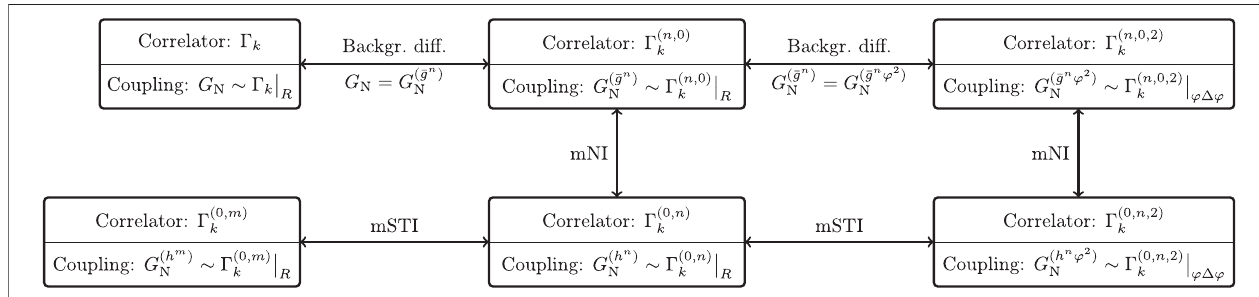
FIGURE3| Displayed aretherelations betweenbackgroundand fl uctuationcorrelationfunctionsintermsofsymmetryidentities.Thebackgrounddiffeomorphism symmetry 46 remainsunbrokenandtriviallyconnectsbackgroundcorrelationfunctions.Thesplitsymmetry( 48 )isencodedinthemodi fi edNielsenidentity(mNI)( 53 )and relates background correlation functions with fl uctuation ones. The quantum diffeomorphism symmetry ( 45 ) is described by the modi fi ed Slavnov – Taylor identity (mSTI) 65 and relates fl uctuation correlation functions. For the purpose of illustration, we have assumed that Γ k (cid:2) Γ k [ g , h , φ ] depends on the background metric g , the metric fl uctuation h , and a scalar fi eld φ . The notation Γ ( n 1 , n 2 , n 3 ) k is then de fi ned as in 32